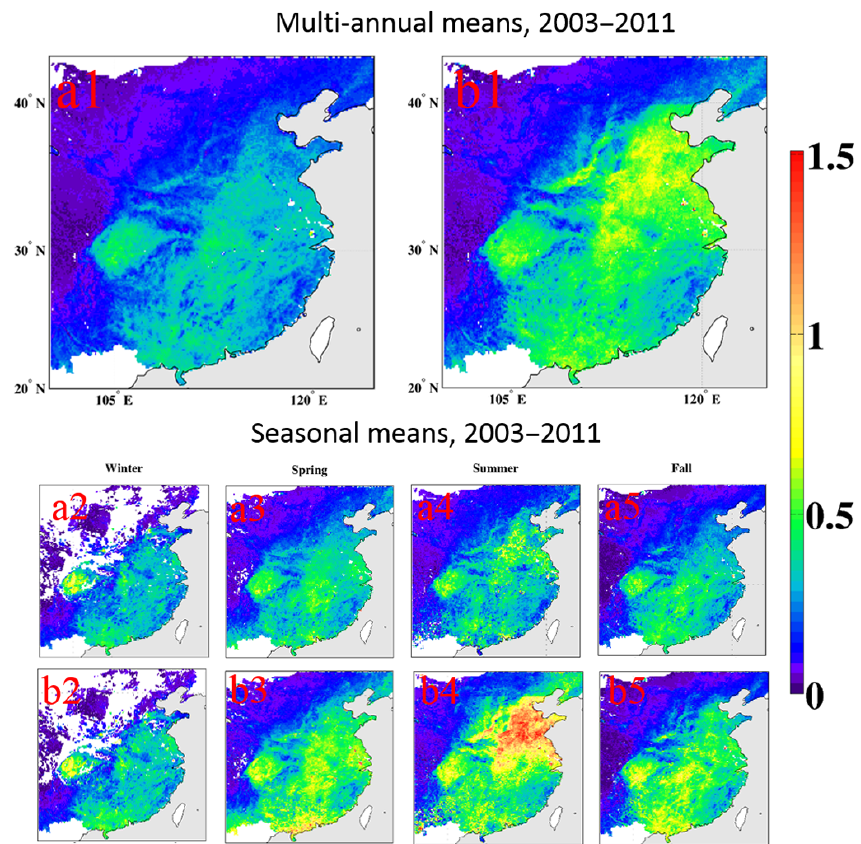
Figure 11. AOD over China for the period 2003–2011 retrieved using ADV and after application of the ExCPP (a) and the ImCPP (b) ag- gregated over the whole year (1) and seasonally (2–5, winter (DJF), spring (MAM), summer (JJA) and fall (SON)